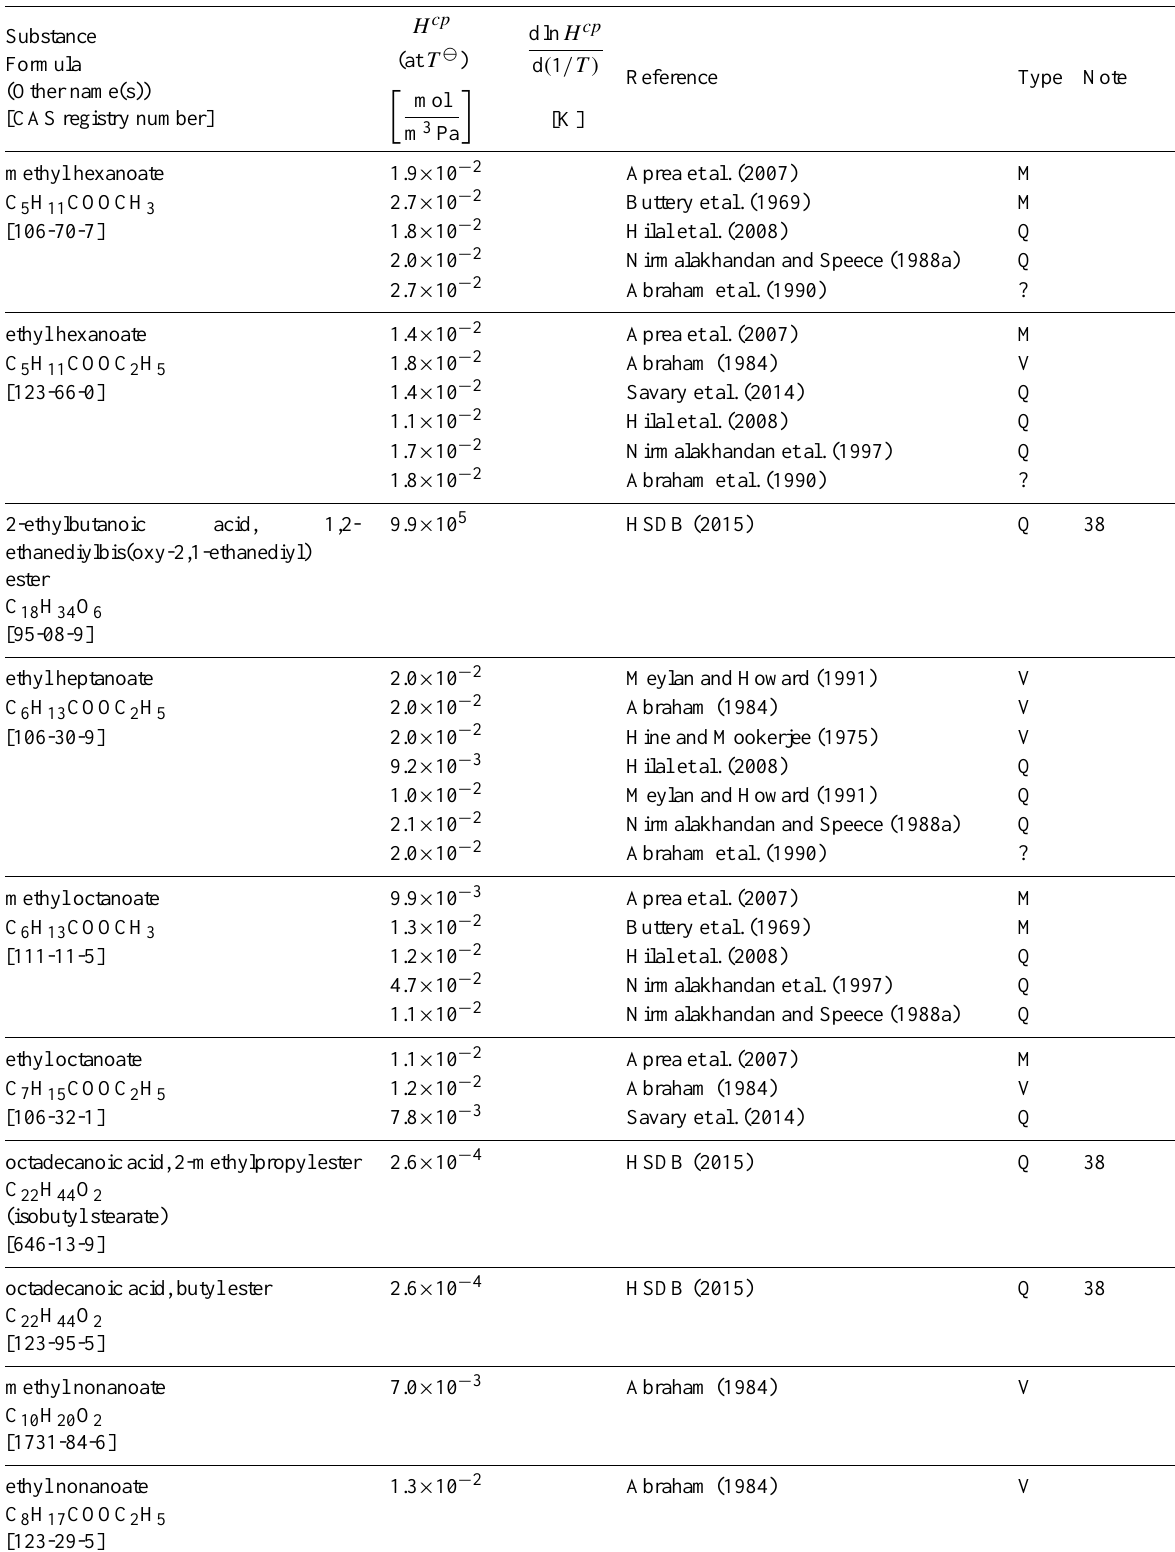
Table 6: Henry’s law constants for water as solvent